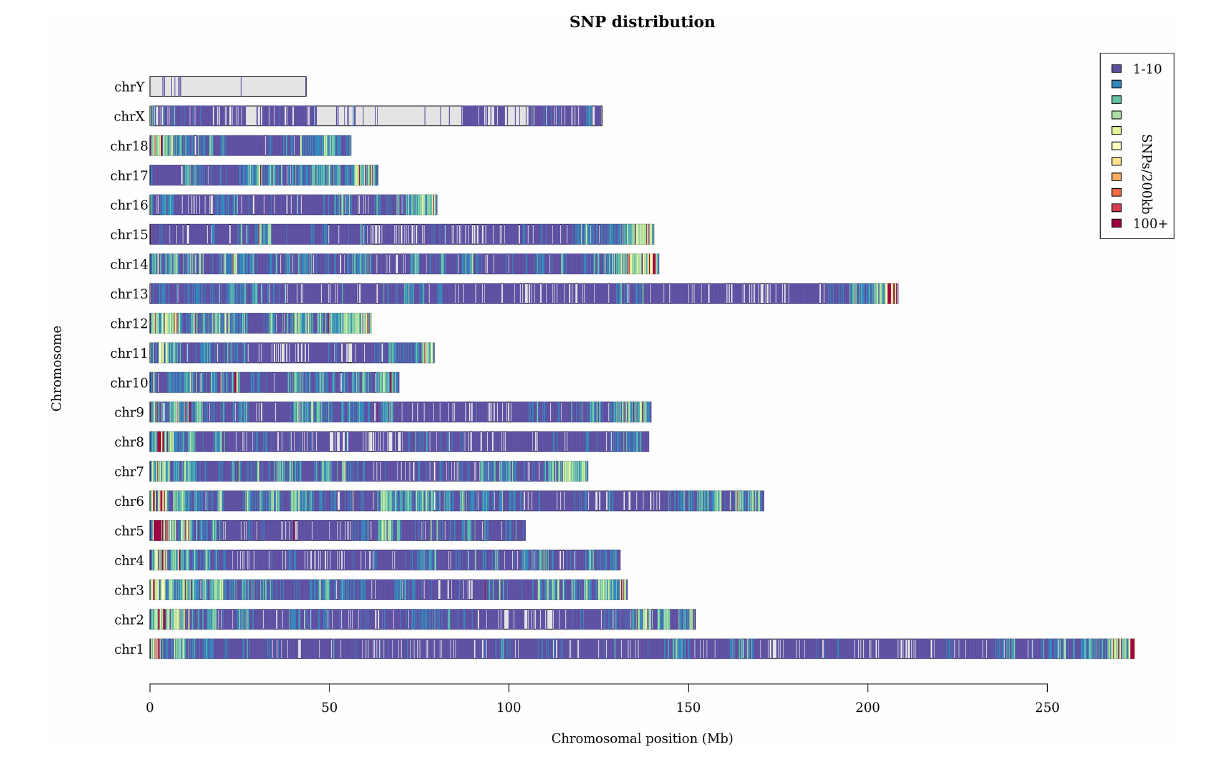
( Figure 1 ), and the average density was approximately 1 SNP